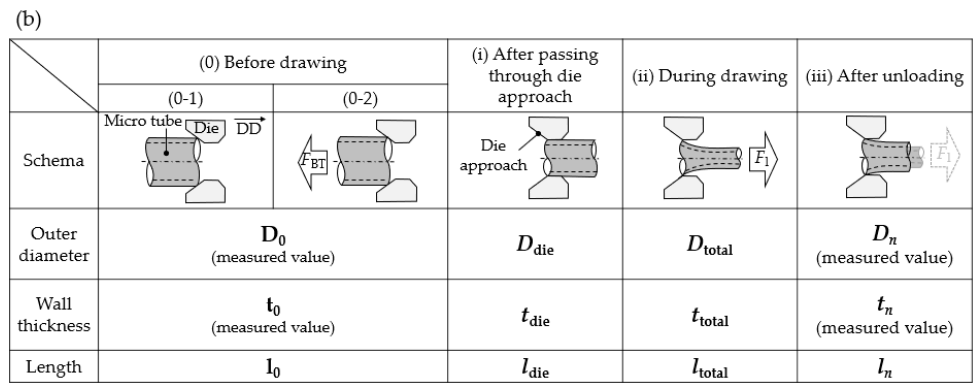
Figure 17. Road map for clarifying the mechanism causing the excessive thinning of the outer diameter. ( a ) Each strain in the stress-strain curve of the drawn tube. The parameters E ’ and E are the apparent elastic modulus and the elastic modulus of the bulk metal, respectively, ( b ) dimensions for each state. The symbol DD indicates the drawing direction. The parameters F l and F BT are the drawing tension and the back tension, respectively.